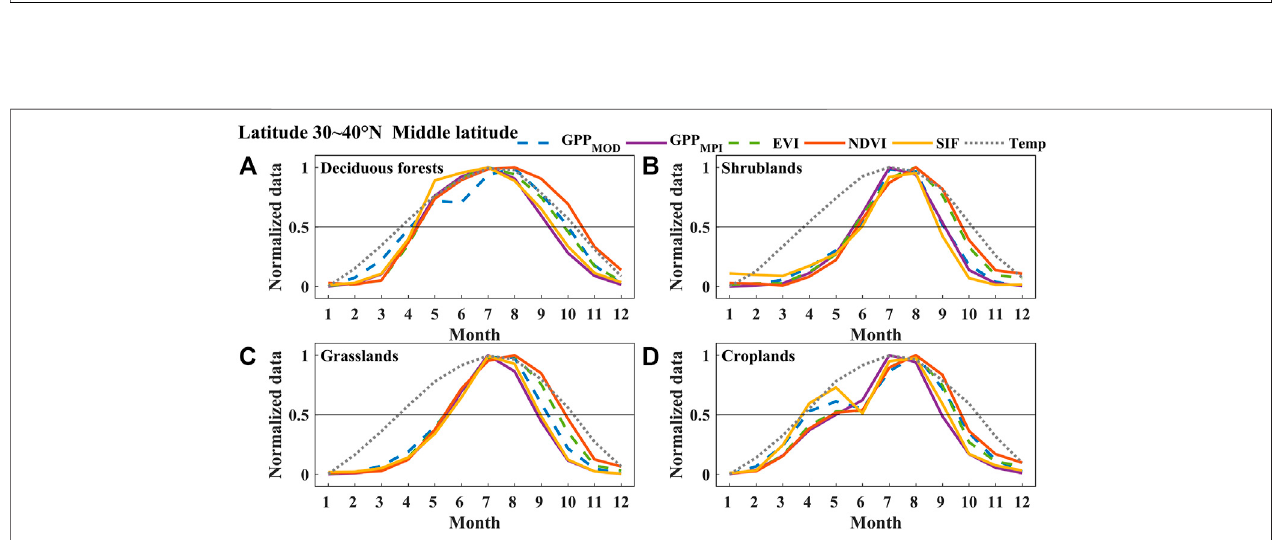
FIGURE 5 | The normalized mean seasonal cycle of area-averaged GPP MOD , GPP MPI , NDVI, EVI, SIF, and Temperature (Temp) of deciduous forests (A) , shrublands (B) , grasslands (C) , and croplands (D) in the middle-latitude region (31 – 40 ° N) of China between 2007 and 2013. Error bars in all subplots represent the monthly standard deviations during 2007 –